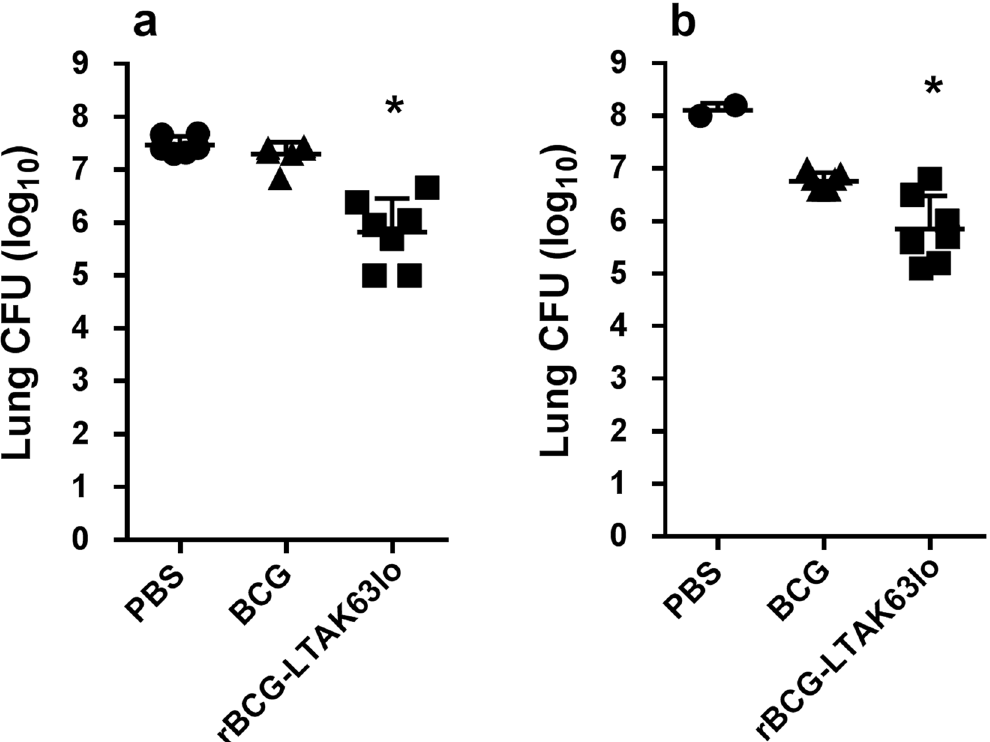
Figure 6. Protection induced by immunization with rBCG-LTAK63 lo against challenge with Mtb Beijing clinical isolate. BALB/c mice were immunized with BCG or rBCG-LTAK63 lo (1 × 10 6 CFU) and a group received PBS and they were challenged intratracheally 12 weeks later with a dose of Mtb Beijing clinical isolate (1 × 10 3 CFU). Bacteria were recovered from the lungs 30 days after challenge. ( a ) Experiment 1 (n = 7 animals) and ( b ) Experiment 2 (n = 7 animals). Bars represent mean ± S.D. ( * ) Differences were considered statistically significant when P ≤ 0.05 as compared to the BCG group (one-way